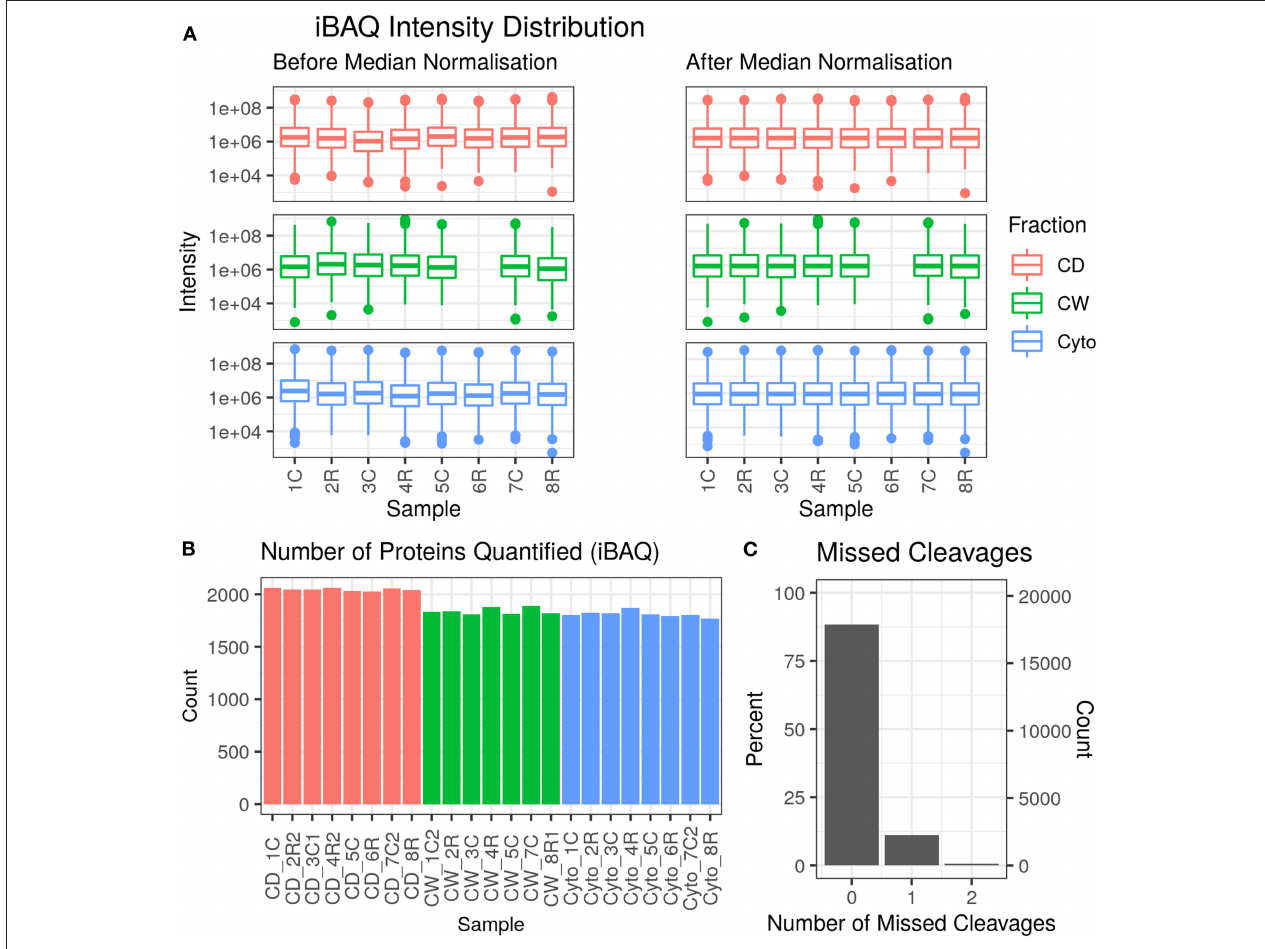
FIGURE 2 | Data quality for primary dataset. (A) Distribution of intensity-based absolute quantification (iBAQ) protein quantifications by sample both before and after median normalisation. (B) Number of quantified proteins by sample. Colour scheme for (A,B) is red for cell debris, green for cell wall, and blue for cytosolic fractions. (C) Frequency of number of missed trypsin cleavage sites in identified peptides revealing nearly 90% of the identified peptides showed zero miscleavages.